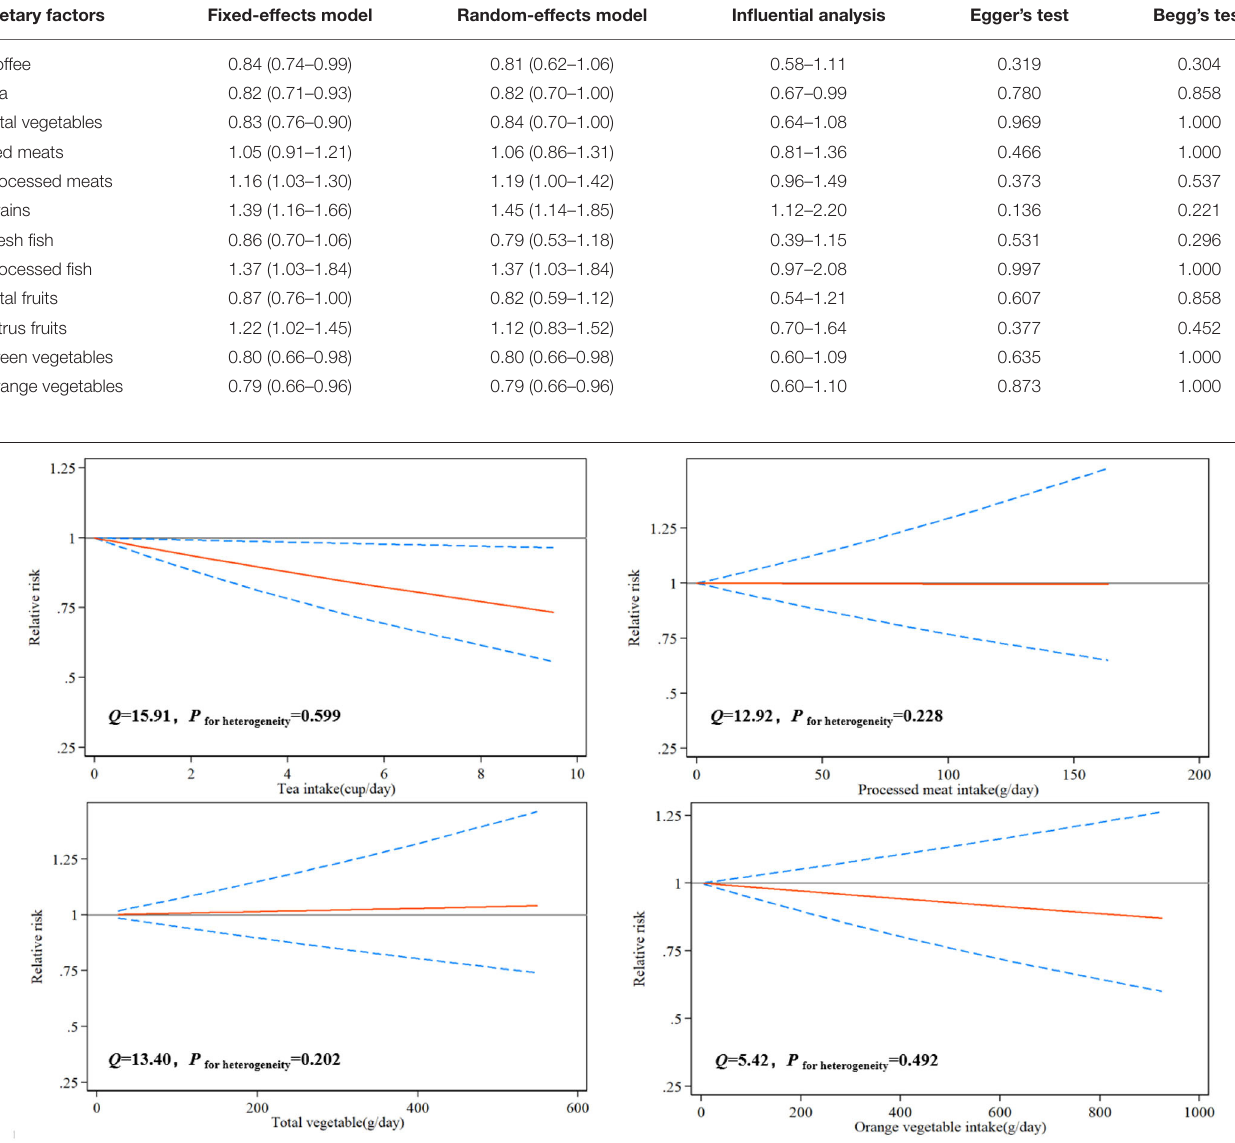
FIGURE 2 | Risk between dietary factors and glioma estimates from the dose-response